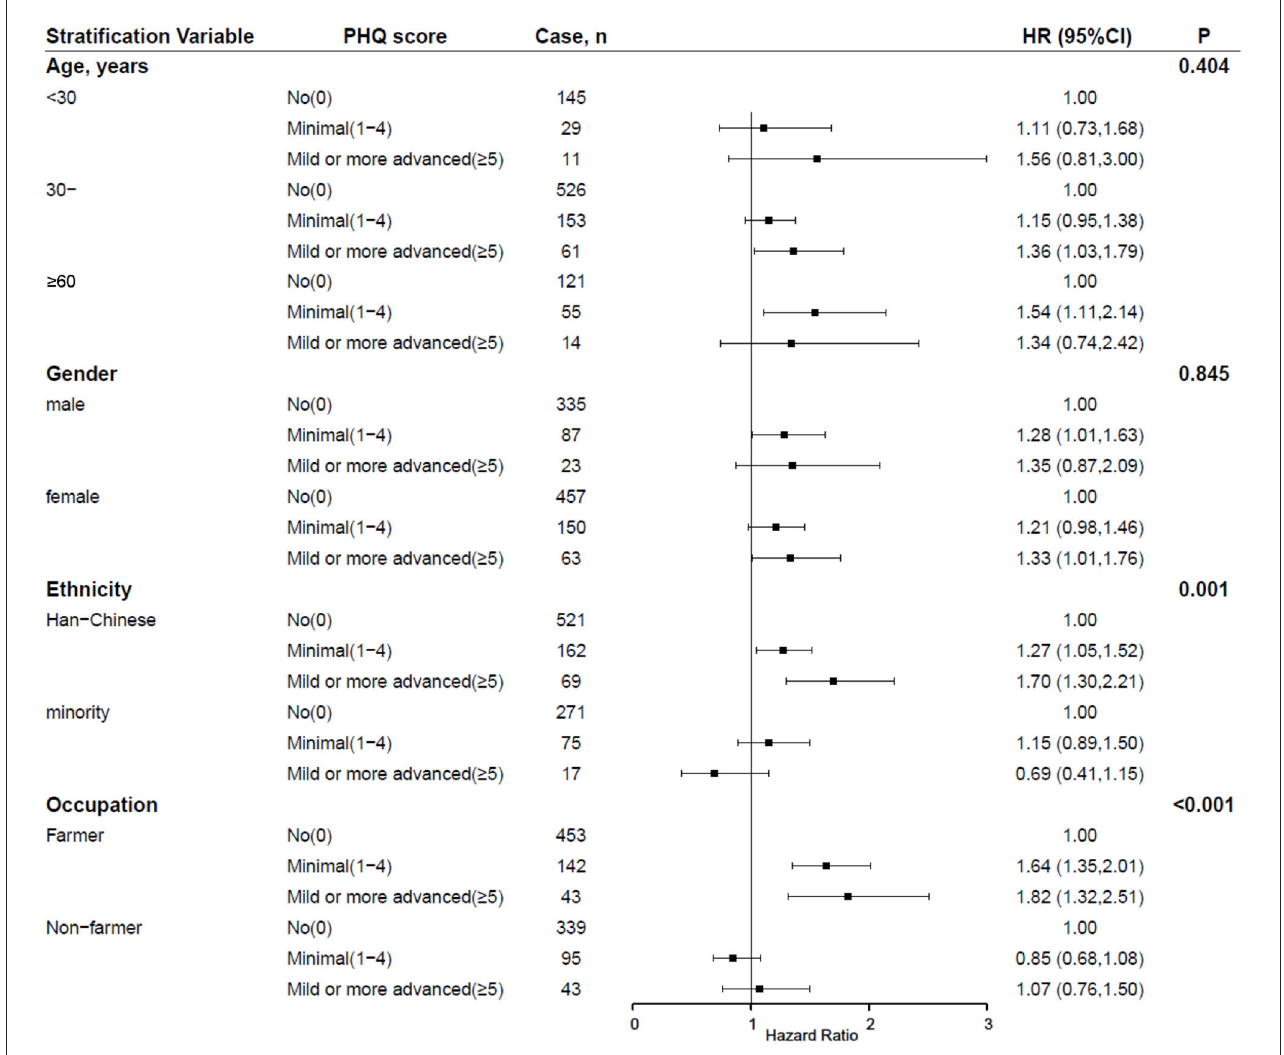
FIGURE2 Interactions between depression and sociodemographic factors on the incident obesity among Chinese adults. Adjusted for age, gender, education, occupation, physical activity, marriage, family relations, alcohol use, dietary habit, hypertension, diabetes mellitus, and dyslipidemia. PHQ-9, Patient Health Questionnaire-9; aHR, adjusted hazard ratio; 95% CI, 95% confidence